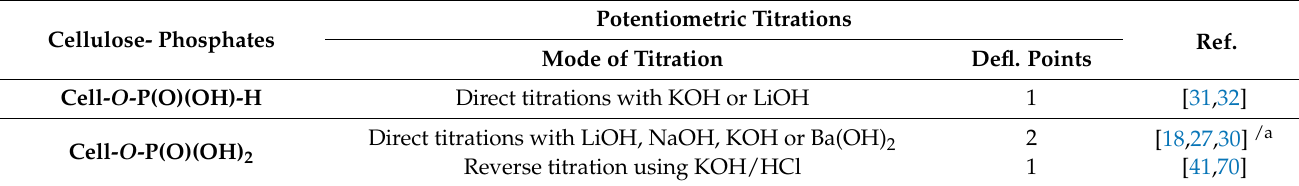
Table 7. Representative methods of potentiometric titration of cellulose- O -phosphoric acids. Figure 12. Schemes of alkalimetric titration of cellulose phosphoric acids. Cellulose- Phosphates